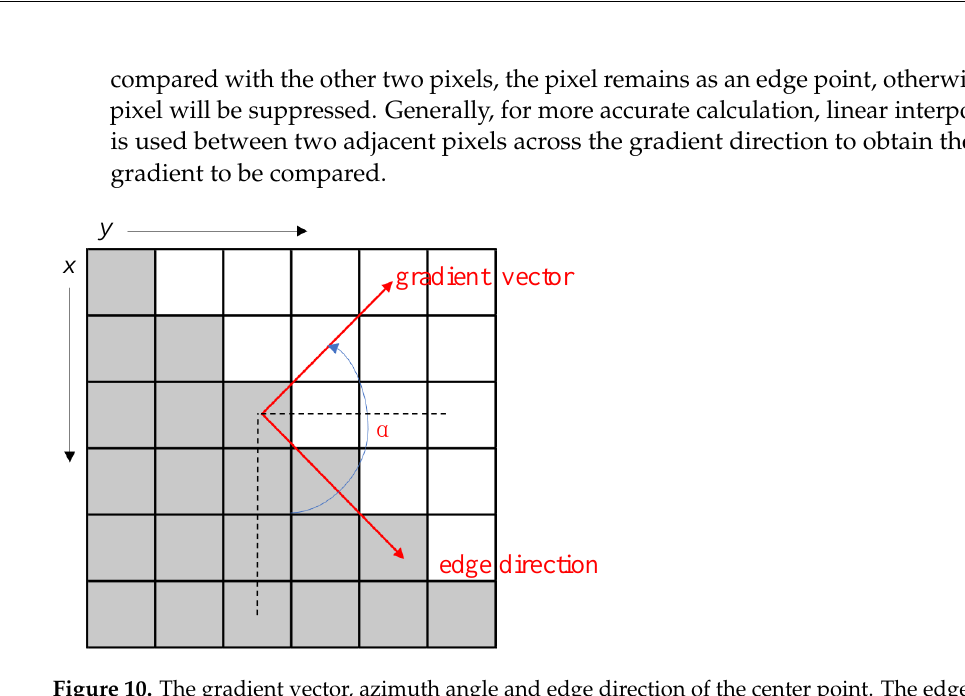
Figure 10. The gradient vector, azimuth angle and edge direction of the center point. The edge of any point is orthogonal to the gradient vector.